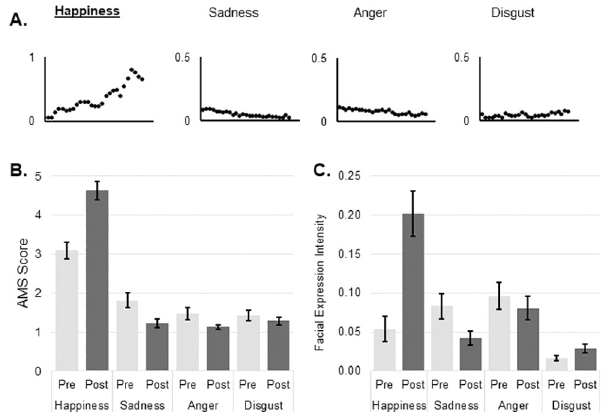
Fig 1. Happiness induction. A: Change in mean values of emotions during the course of video as measured by automated facial expression analysis; B: Mean and SE of subjective mood evaluation as measured by AMS; C: Mean and SE of objective mood evaluation as measured by automated facial expression analysis. AMS: Actual Mood State; SE: Standard Error.